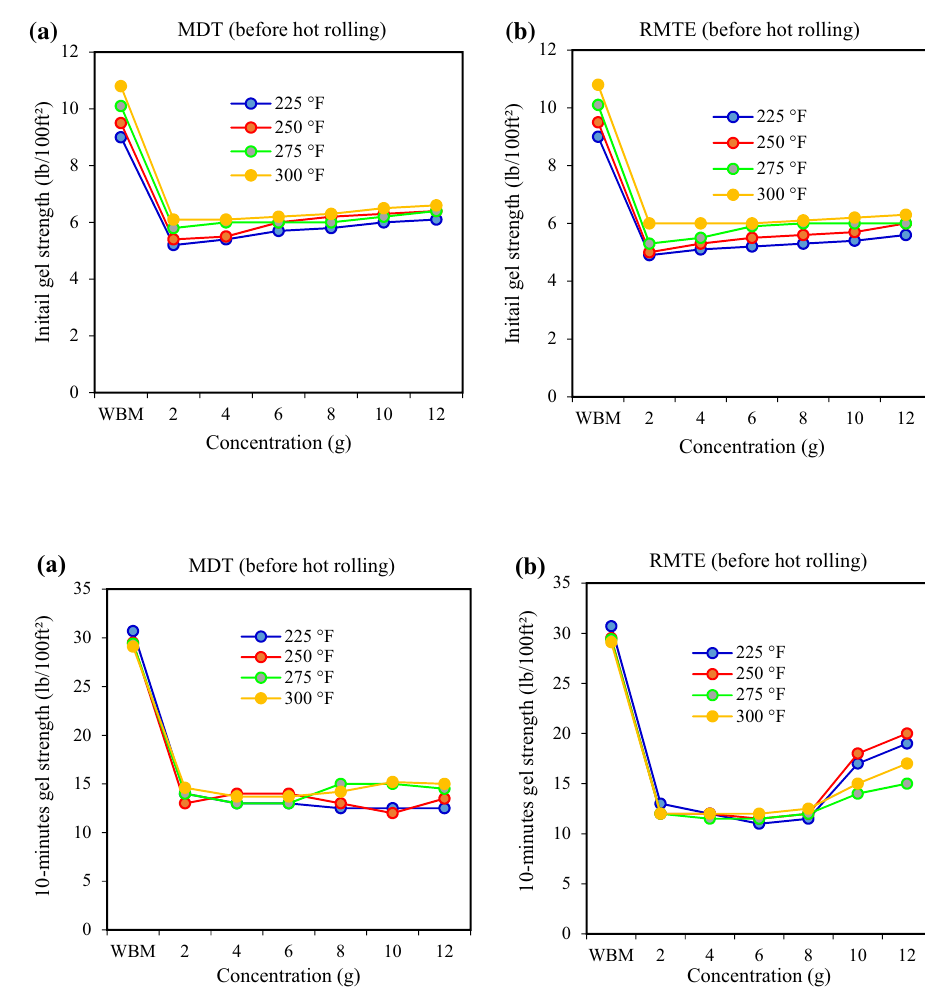
Fig. 8 Initial gel strength of a MDT and b RMTE at different temperatures